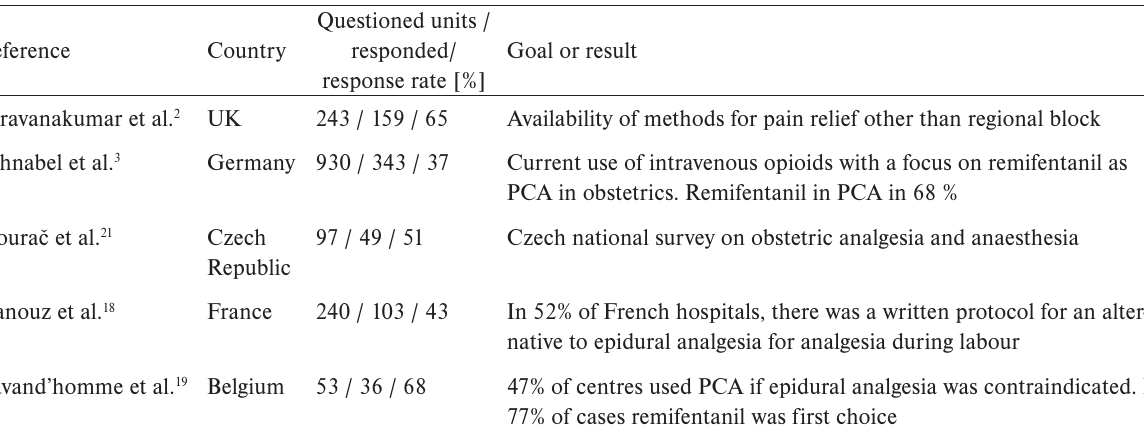
Table 1. National surveys on labour analgesia including remifentanil.